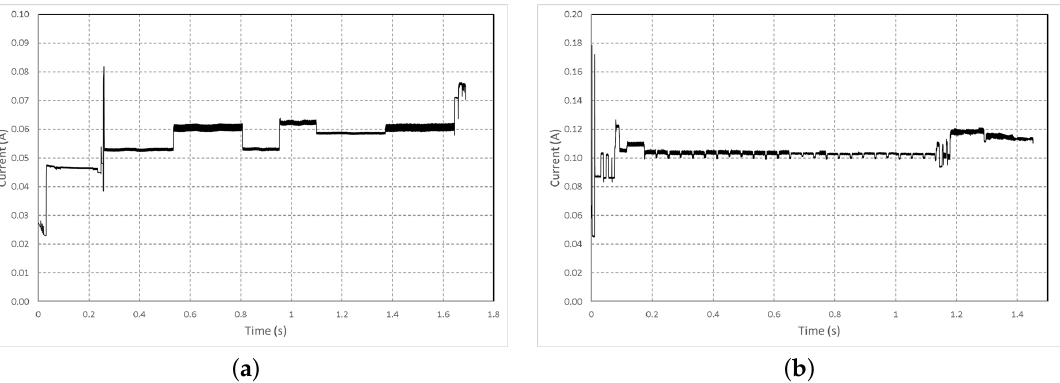
Figure 4. Measured current ( a ) during the boot sequence. ( b ) during the camera